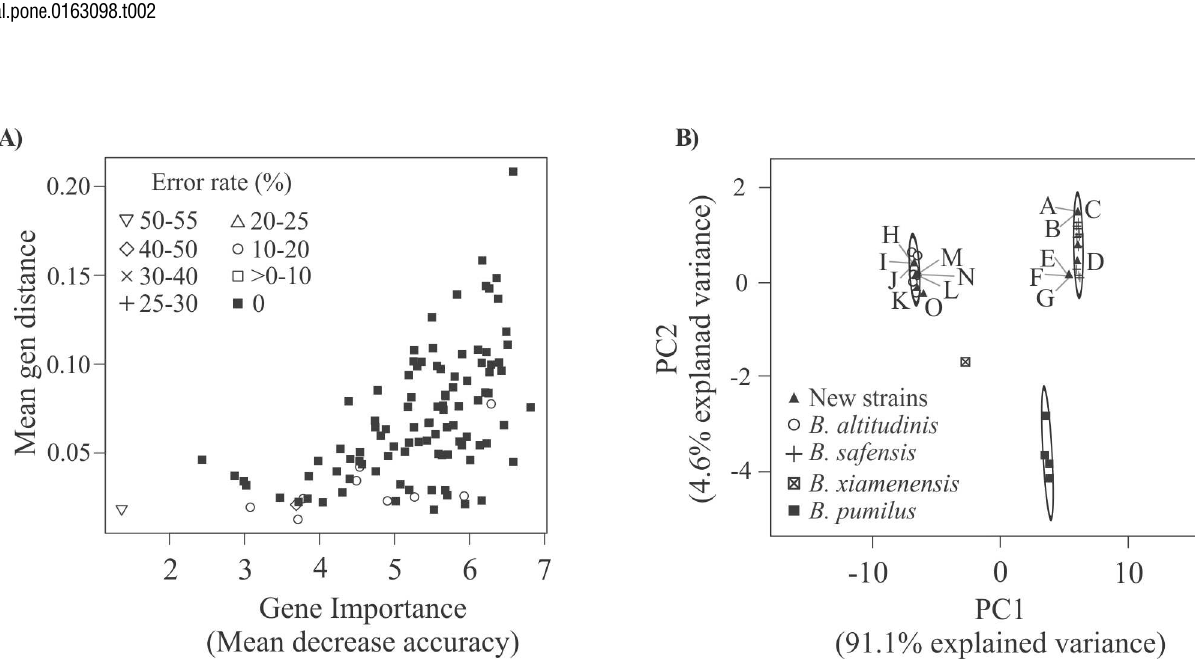
Fig 6. Ranking of genes based on their RF importance and PCA for outlier detection. A) Importance and error rate plot . Importance of each gene was computedusing RF and plotted versus its gen distance mean. Symbols representing the percentageof the